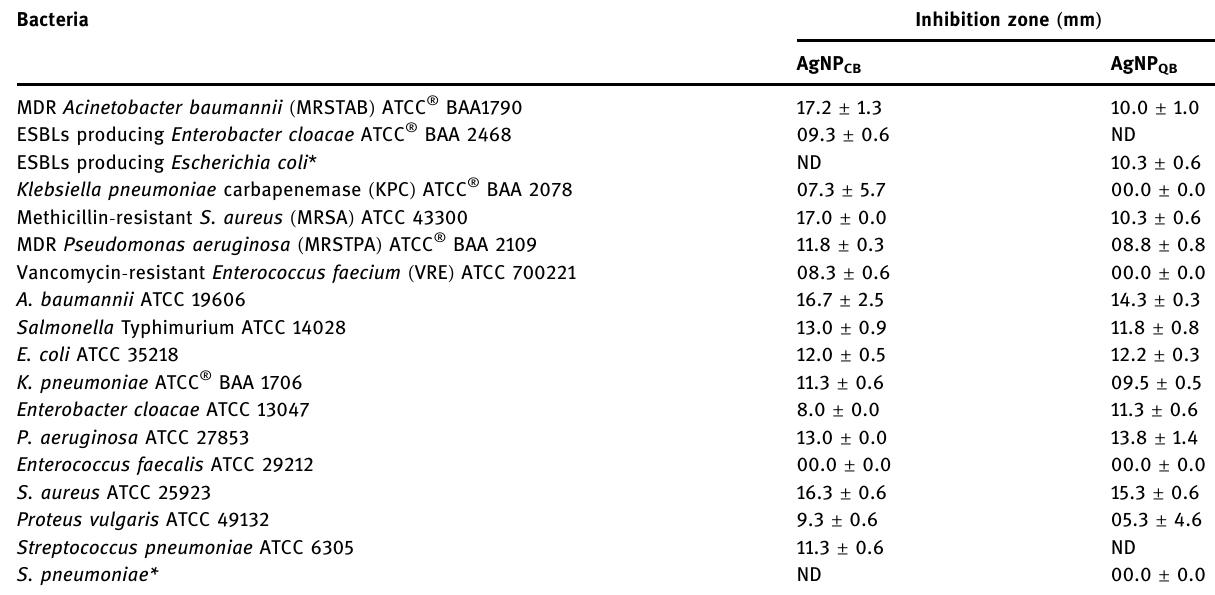
Table 2: Antibacterial activity of biologically synthesized AgNP CB and AgNP QB Bacteria